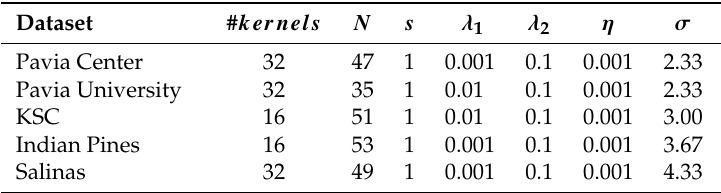
Table 2. Parameter values of CNN-RSL trained with 1% labeled pixels of each class using Random Grid Search Cross-Validation framework